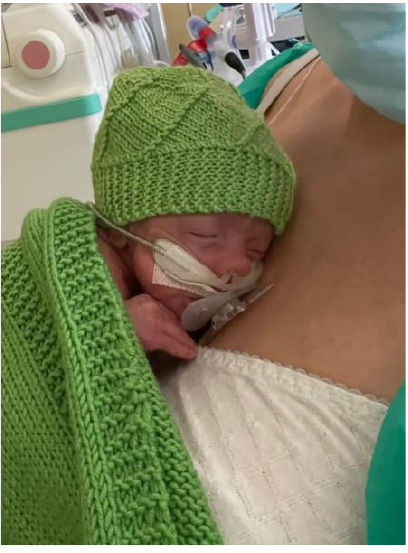
Figure 1. Mother – infant dyad during an SSC session. Figure 1. Mother–infant dyad during an SSC session. Infants who underwent SSC during the first three weeks of life, who were born between 27 + 0 and 32 + 6 weeks’ gestation and with a birth weight under 2000 g were eligible for the study (Table 1). Parents were informed and consented to the SSC; the minimum expected duration of each SSC session was 90 min. Exclusion criteria were ongoing proven or suspected sepsis or necrotizing enterocolitis, the presence of congenital malformations, intraventricular hemorrhage (IVH) grade 3–4, ≥ 5 central apneas in the hour before an SSC session, and severely ill